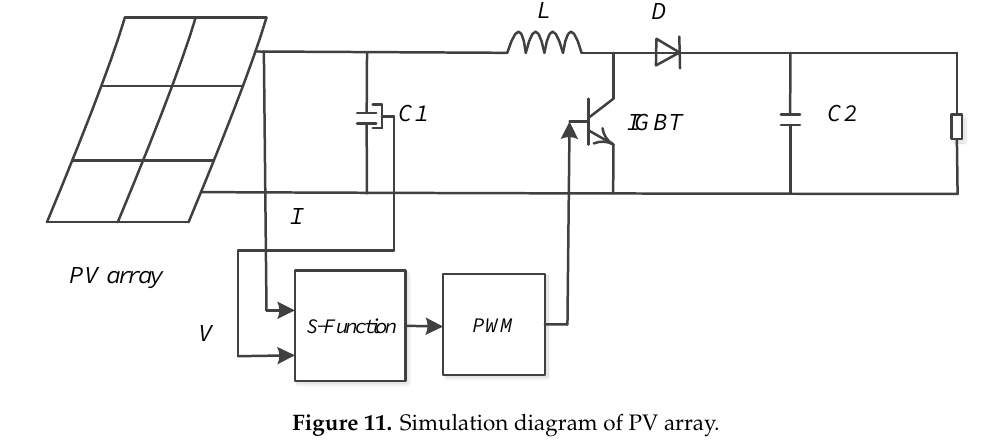
Figure 11. Simulation diagram of PV array. Table 1. Parameters of simulation components.